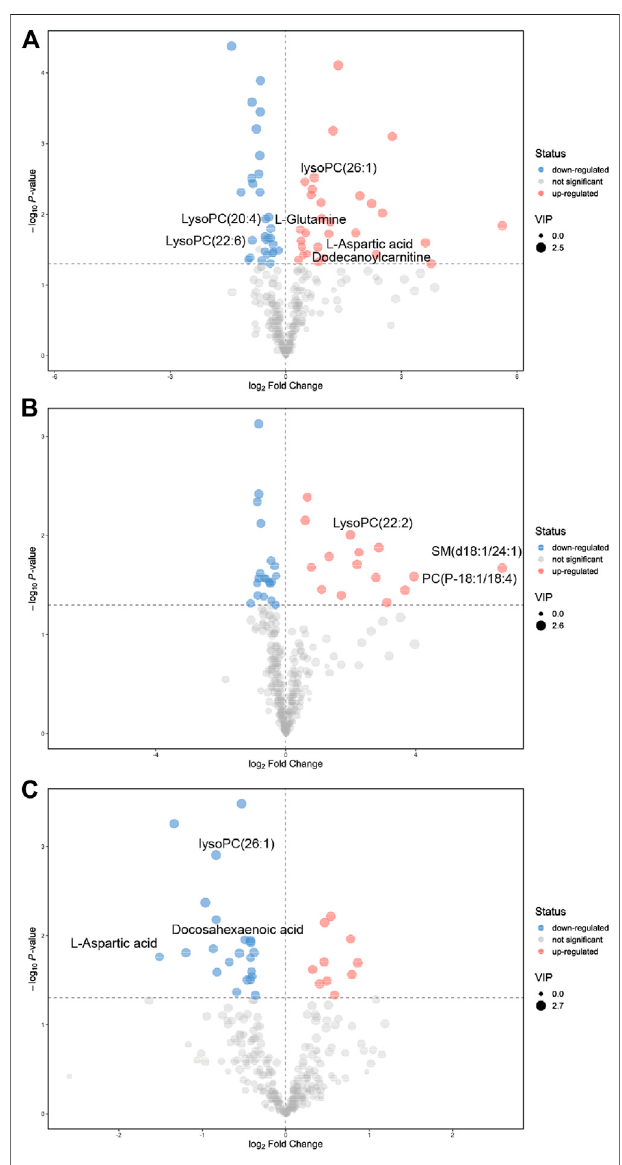
FIGURE 4 | Signi fi cantly changed metabolites were shown in the volcano fi gure. (A) raw SO vs. control, (B) PSO vs. control, and (C) PSO vs. raw